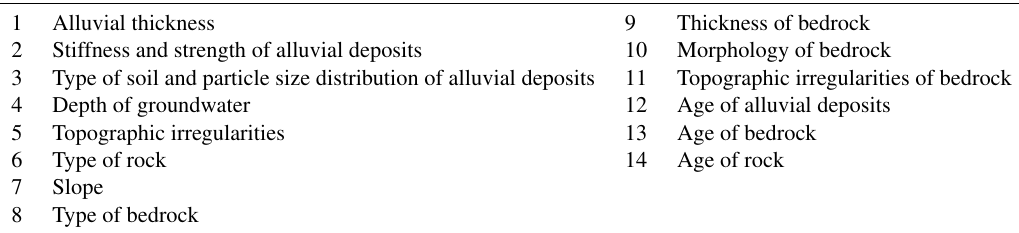
Table 1. Relevant criteria that influence seismic microzonation.